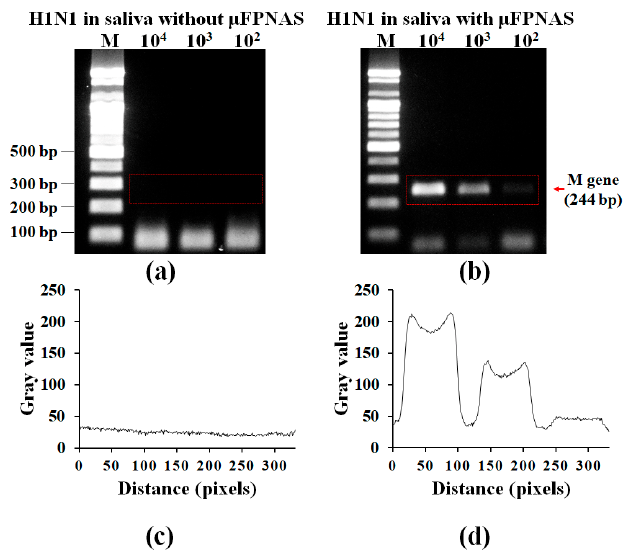
Figure 5. Validation of on-chip preconcentration and RT-PCR of H1N1 in saliva by gel electrophoresis. Gel electrophoresis of PCR products ( M gene) from 1 mL saliva containing influenza A virus H1N1 at di ff erent concentration (10 2 –10 4 TCID50 / mL) without preconcentration ( a ) and on-chip preconcentration and RT-PCR using µ FPNAS ( b ). ( c , d ) Analysis of intensity levels for the red rectangular areas in ( a , b ), respectively.